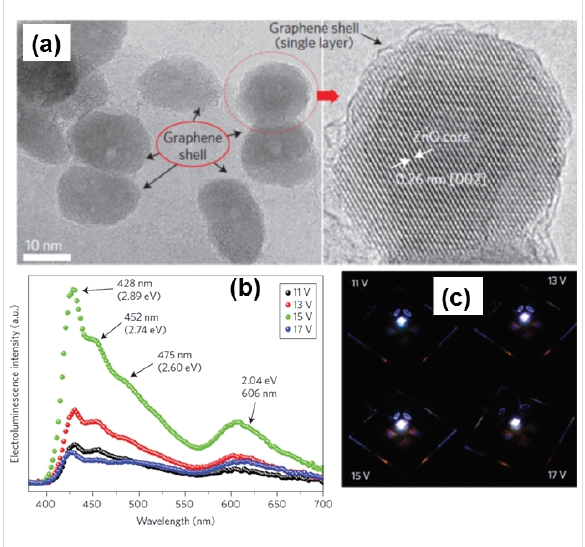
Figure 9: (a) High-resolution TEM images of ZnO quantum dots covered by graphene. The graphene shell layer of the ZnO-core quan- tum dot covered by graphene looks like a single graphene layer. To the right, a magnified image shows the structure of the ZnO core and graphene monolayer. The ZnO petals grow along the [2] direction. (b) Electroluminescence spectra of the fabricated ZnO–graphene quasi-quantum dot LED device with applied voltage from 11 to 17 V. (c) Photograph of light emission at 11, 13, 15 and 17 V applied voltage bias, respectively. Reprinted by permission from [224], copyright 2012 Macmillan Publisher